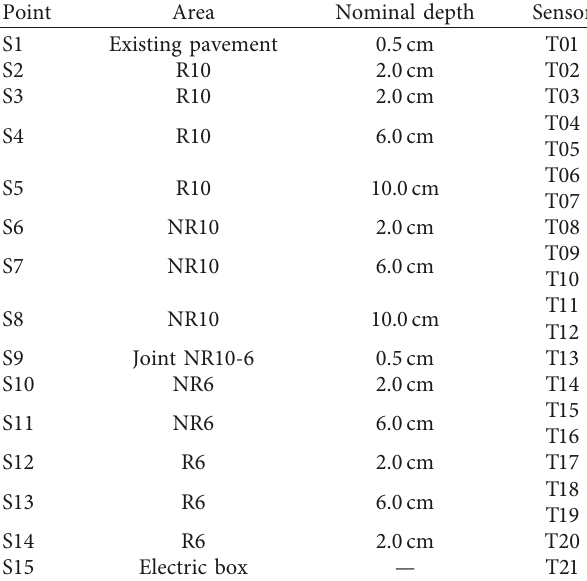
Table 1: List of sensors and their locations.